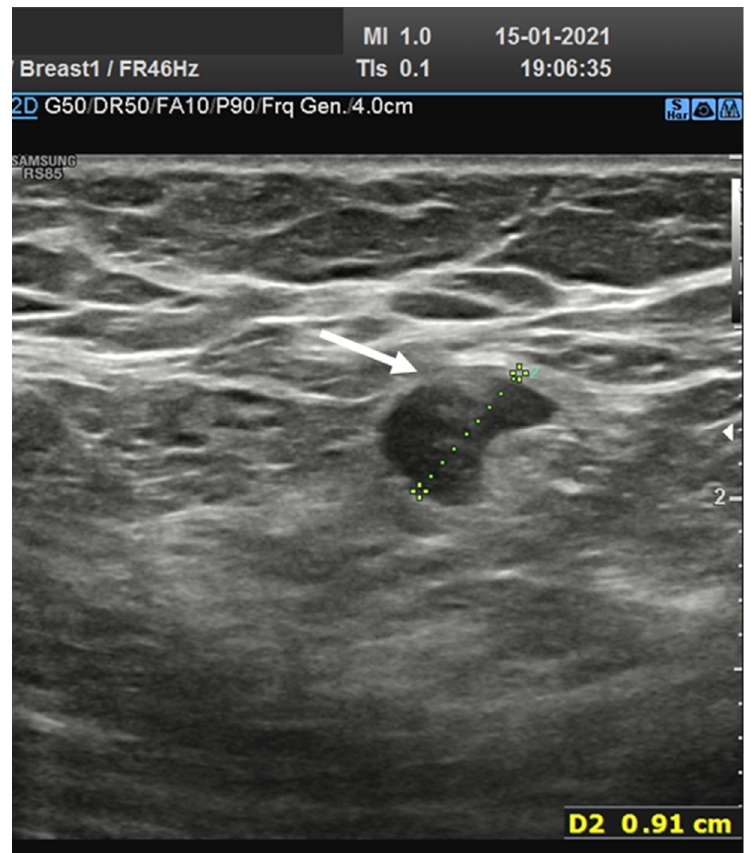
Figure 2. Axillary lymph node with eccentric asymmetric cortical thickening with wide echogenic hilum and oval shape.